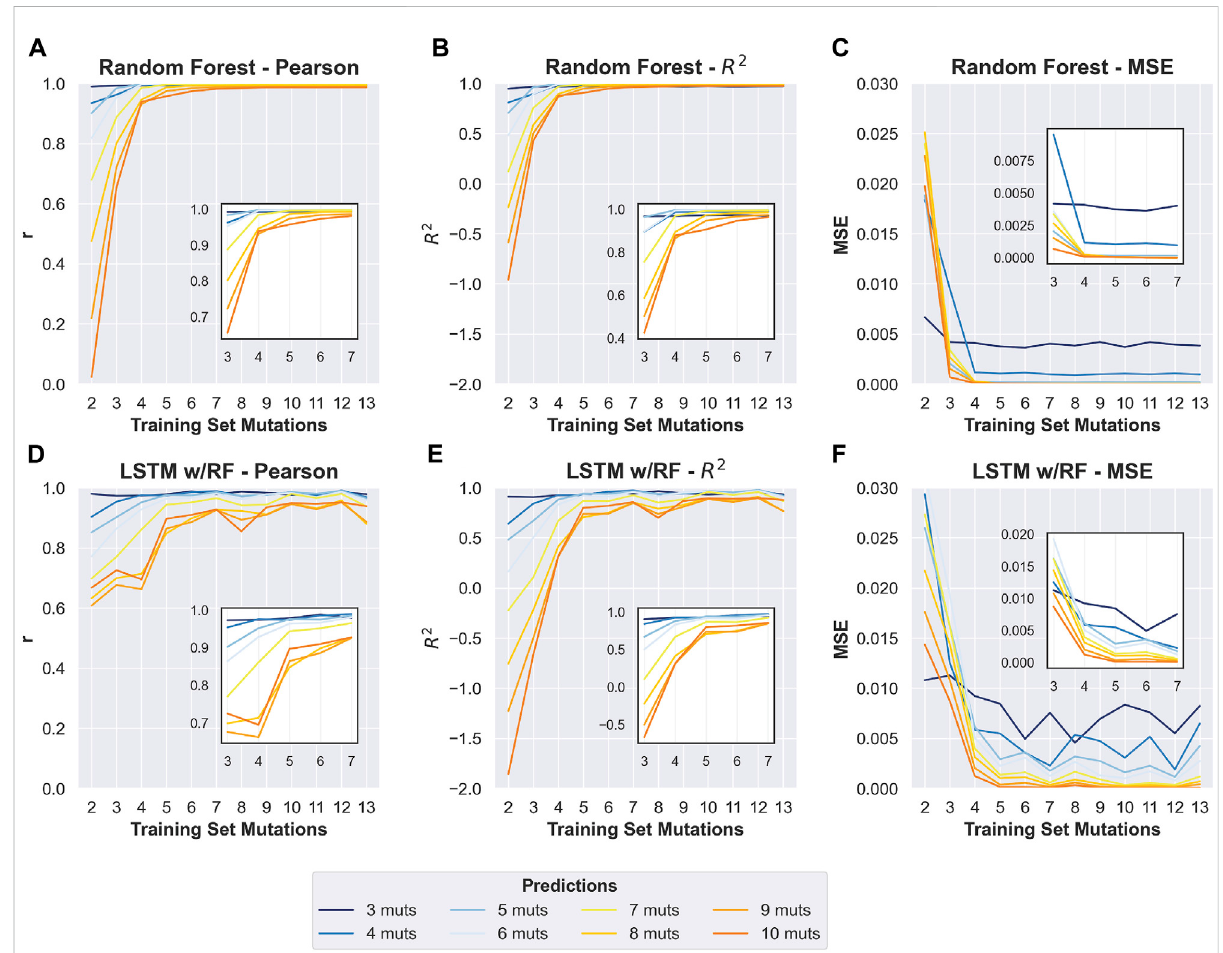
FIGURE 3 Improvement in prediction accuracy when including sequences with increased mutational distances in the training data. Changes in Pearson r , R 2 , and mean squared error (MSE) of prediction-observed correlation ( y -axis) with increasing numbers of max mutations within the training data ( x -axis). Training sets included all sequences up to and includingthe y -axis value. (A – C) Results obtained for therandomforest model. (D – F) Results from the LSTM model. For each plot, colors indicate the numbers of mutations in sequences in the test data (see key). Insets show changes to the same prediction accuracy measurement with the 3 – 7 mutation training data, to allow more visual